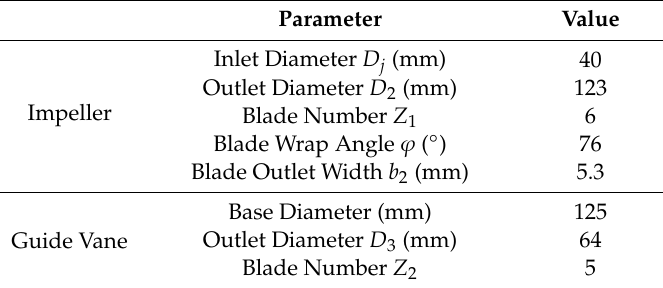
Table 1. Parameters of the model jet centrifugal